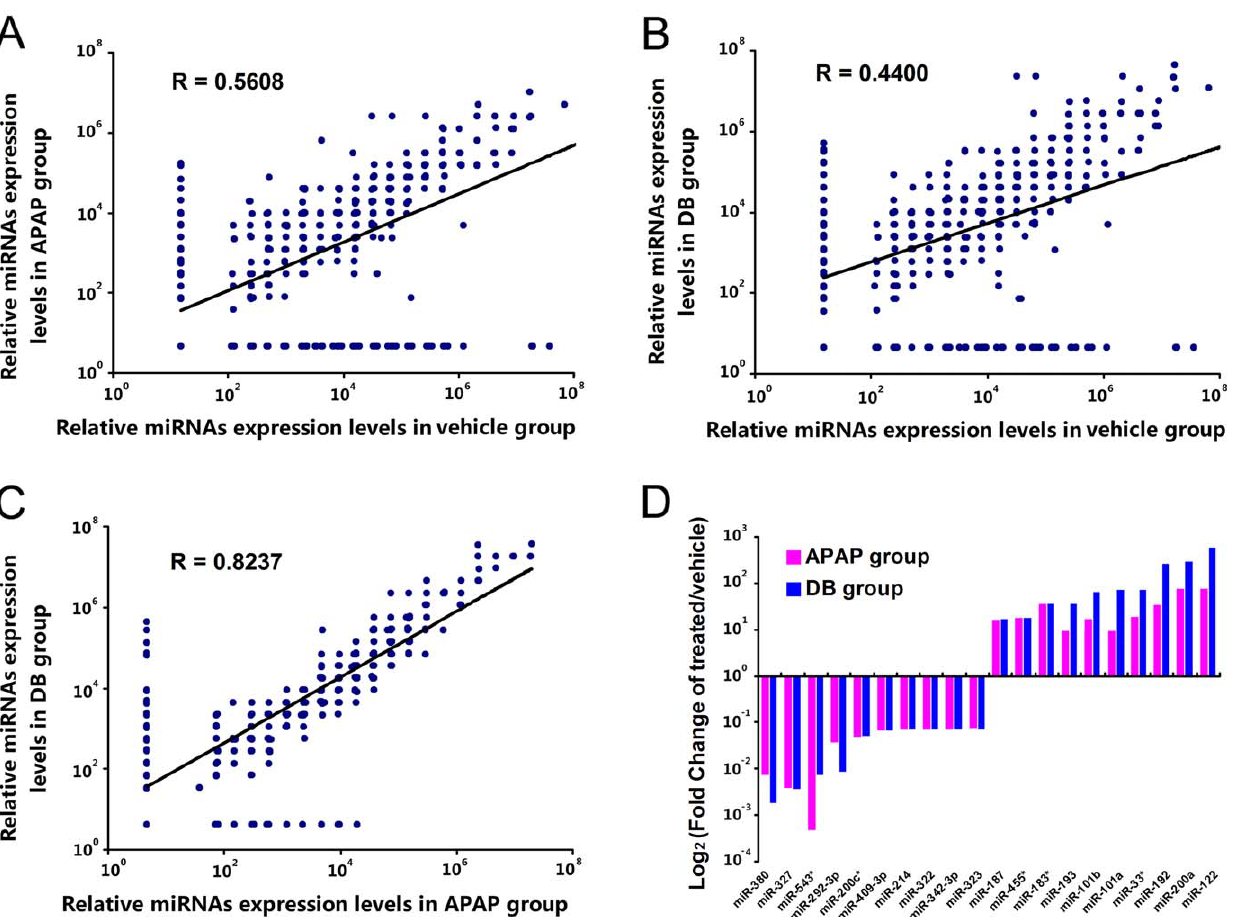
Figure 2. Analysis of serum miRNA expression profiles explored by TLDA. (A) Correlation and scatter plot analysis of relative miRNAs expression levels in APAP group and vehicle group; (B) Correlation and scatter plot analysis of relative miRNAs expression levels in DB group and vehicle group; (C) Correlation and scatter plot analysis of relative miRNAs expression levels in DB group and APAP group; In Panel A, B and C, the relative expression levels of each miRNA to an internal control was calculated by using the equation 2 2 D CT 6 10 7 , in which D C T =C T miRNA 2 C T U6 . The C T value of ‘‘Undetectable’’ was calculated as 40. (D) Top 10upregulated and downregulatedserum miRNAs detectedbyTaqManlow-densityqPCRarray. Fold change of treated/vehicle was calculated by using the equation 2 2 DD CT , in which DD C T =(C T miRNA 2 C T U6 ) DILI group 2 (C T miRNA 2 C T U6 ) vehicle group . And serum miRNAs were ranked by the fold change of the group with the largest upregulated fold (n=10 per group, pooling).